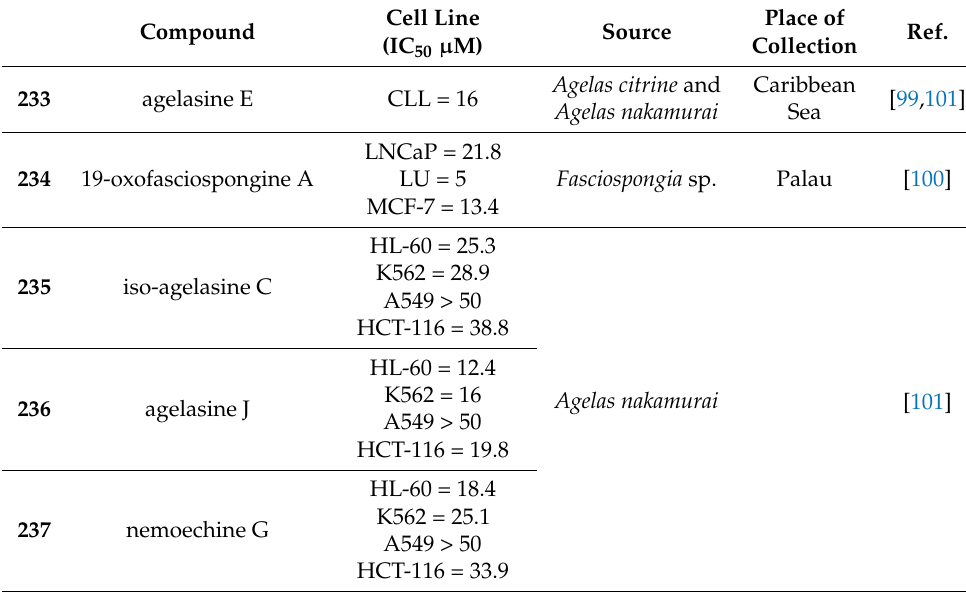
Figure 19. Diterpen alkaloid structures isolated from sponges. Table 19. Cytotoxic activity of diterpen alkaloids.